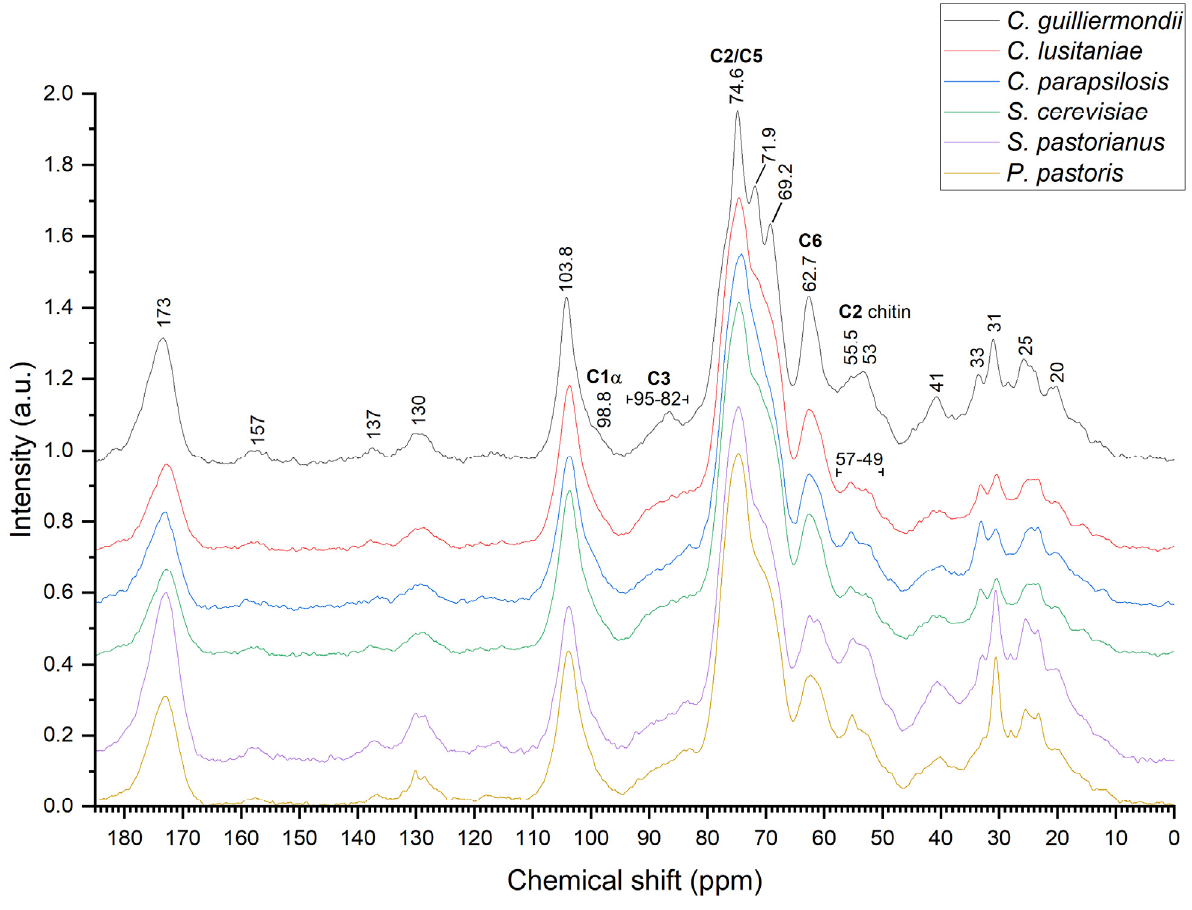
Figure 4. 13 C carbon molecule chemical shift of hot water-extracted β -glucans from 6 yeast strains: (from top to bottom) Candida guilliermondii , C . lusitaniae , C . parapsilosis , Pichia pastoris , Saccharomyces